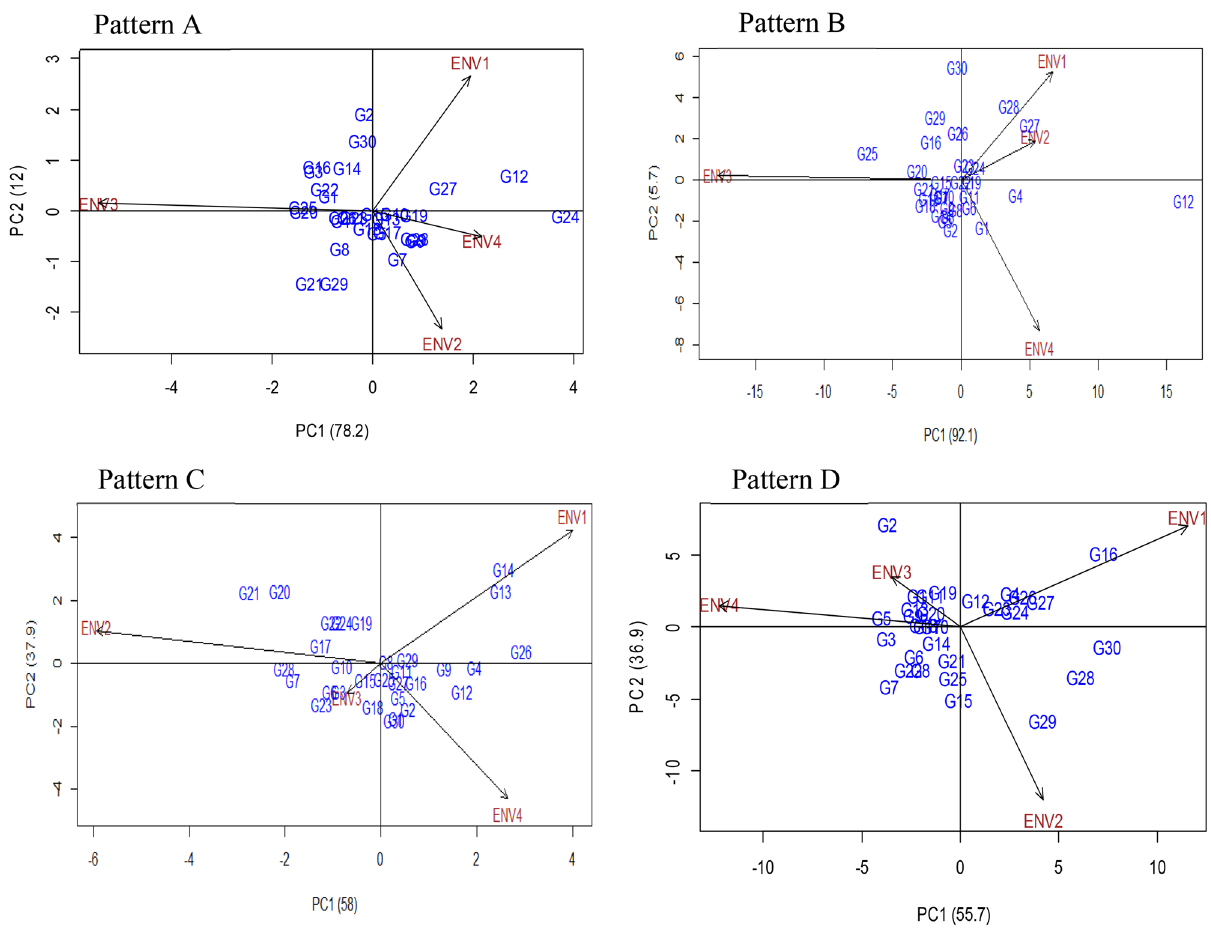
Figure 8. The biplot ‘AMMI 2’ illustrated the first two principal components (PC1 and PC2) effects of genotype plus GE interaction effect of 30 V . subterranea genotypes under two season two location for total number of pods (Pattern A), fresh pod weight (Pattern B), hundred seed weight (Pattern C), yield kg/ha (Pattern D). The biplots were created based on Centering = 0, SVP = 2, Scaling = Mean performance and comparison of genotypes. The means comparison and average performance of 30 V . subterranea genotypes over four environments were listed in Table 5. Over the location, all the genotypes showed significant variation for total number of pods (TNP), fresh pod weight (FWP), hundred seed weight (HSW), and Yield per hectare. The total number of pods ranged from 73 (G24) to 92 (G4) with an average of 8484.67 ± 0.46.